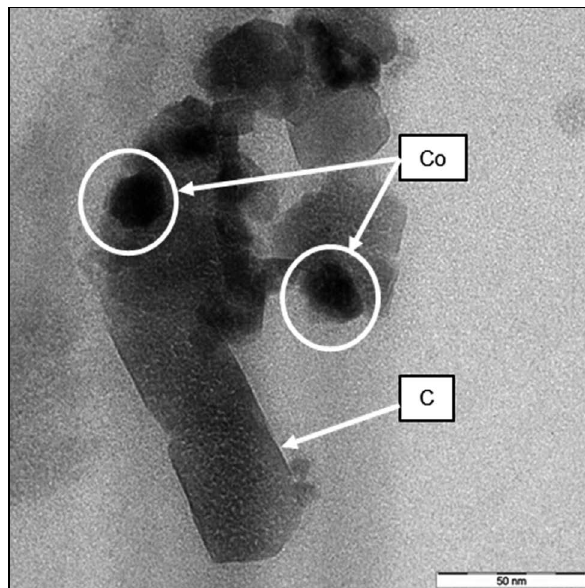
Figure 7. TEM micrograph of fresh Co 47.5 /C 47.5 -PVC 5 powder by using 100,000x magnification.